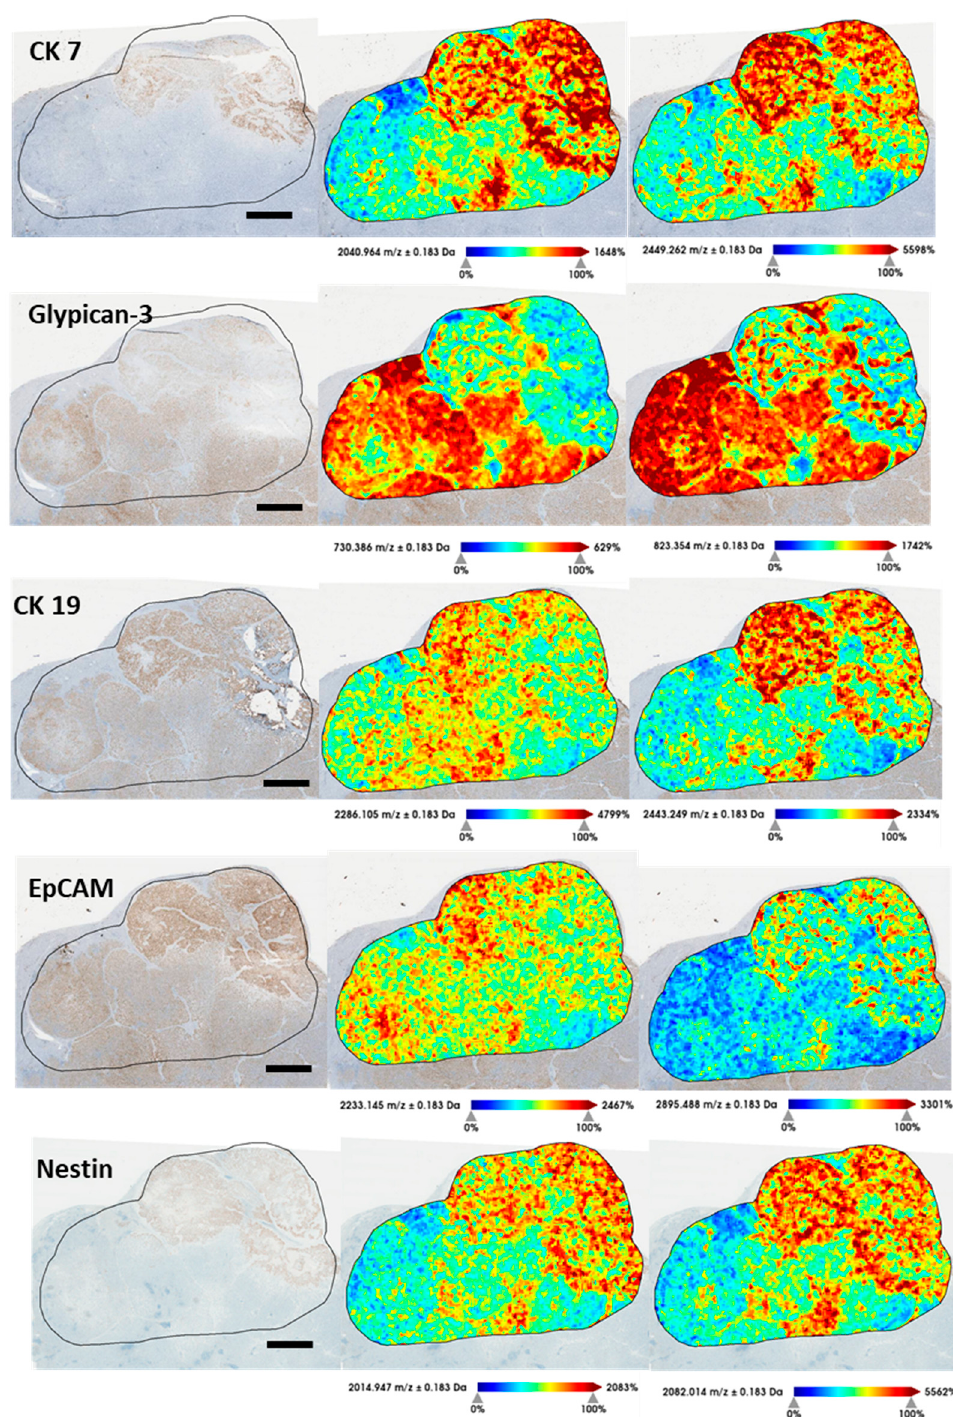
Figure 5. Comparison of a selection of tryptic peptides derived from current IHC markers and the corresponding IHC for Patient 3. Scale bar = 3 mm. It can be seen that there is good overlap between the CK7-labeled zones and the peptides derived from in silico digestion of the same protein. It can also be seen that tryptic peptide is detected in areas not labeled by CK7; these areas, upon careful morphological analysis, had areas of cholangiocyte differentiation. Similarly, good overlap can be seen between the markers glypican-3, Nestin, EpCAM, and CK19 with related tryptic peptides. Cases 1, 2, 4, and 5 are reported in Supplementary Materials.